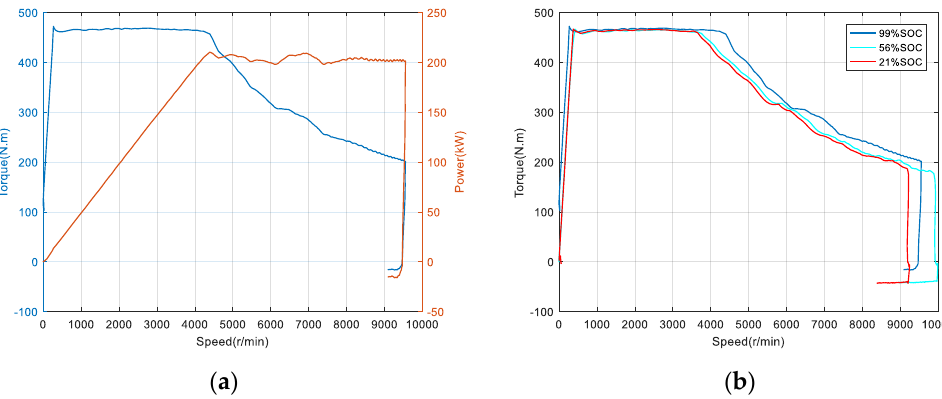
Figure 9. Curves of the output torque and power in ( a ) APO = 100%; ( b ) different SOC.